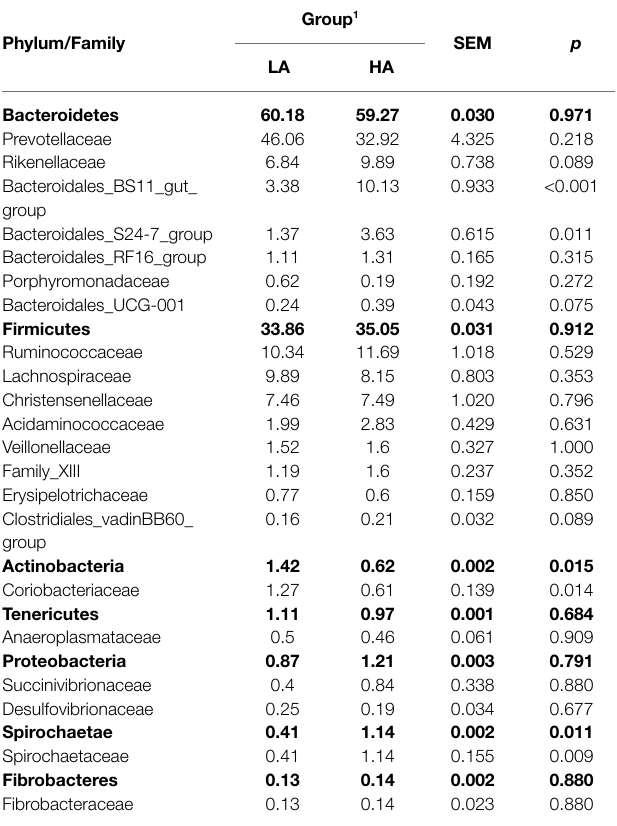
TABLE 4 | Phyla and families with relative abundance of >0.1% in the rumen bacteria of LA and